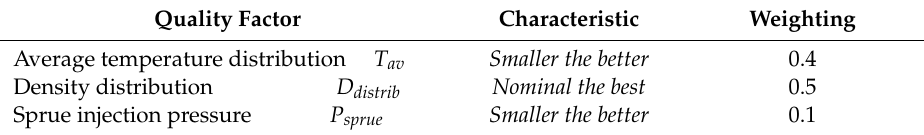
Table 4. Definition of quality factors (optimization criteria) for Taguchi